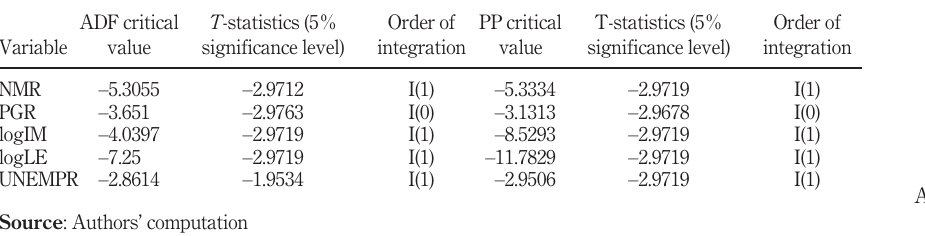
Table 2. ADF and PP